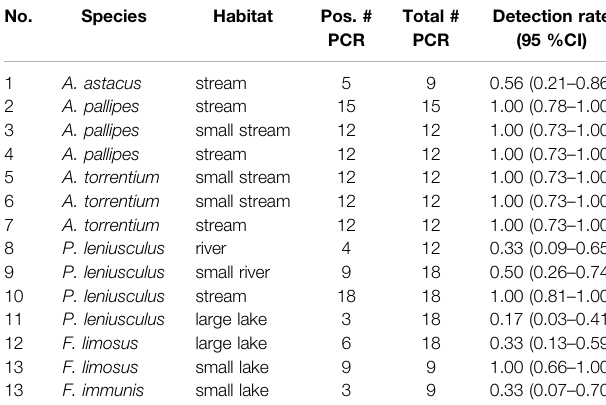
TABLE 3 | Results of species-speci fi c eDNA detection from sampling sites used for primer evaluation (see Figure 1 and Table 2 for location and characteristics of water bodies). Detection rate is given as proportion of positive endpoint PCRs (including 95% con fi dence